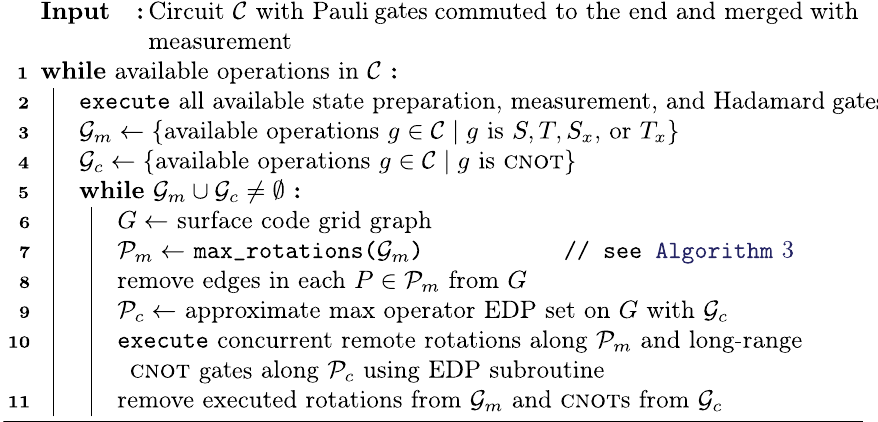
Algorithm 6. EDPC implementation : the EDPC algorithm (Algorithm 4) differs from our implementation in that it greedily tries to execute CNOT gates